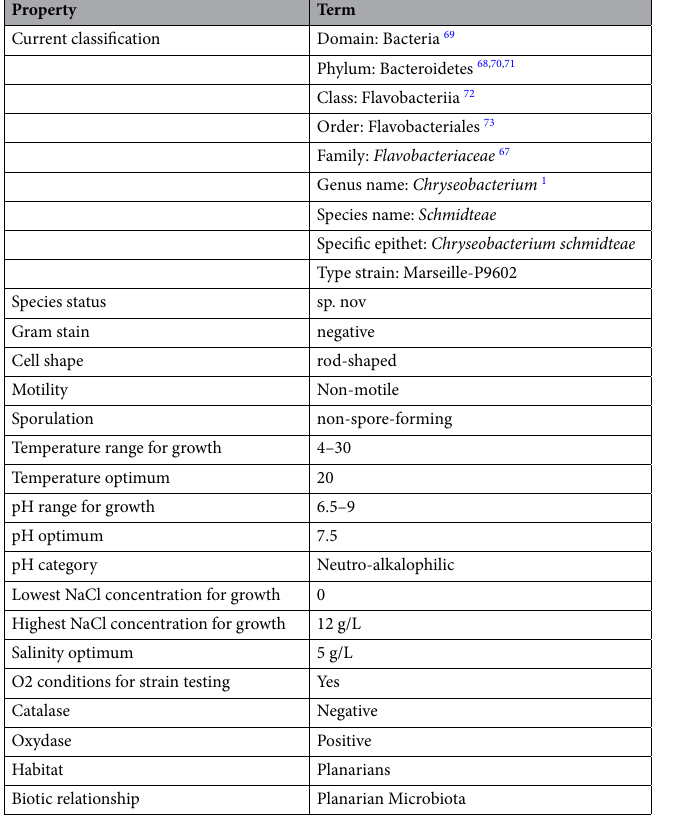
Table 2. Classification and general features of Marseille-P9602